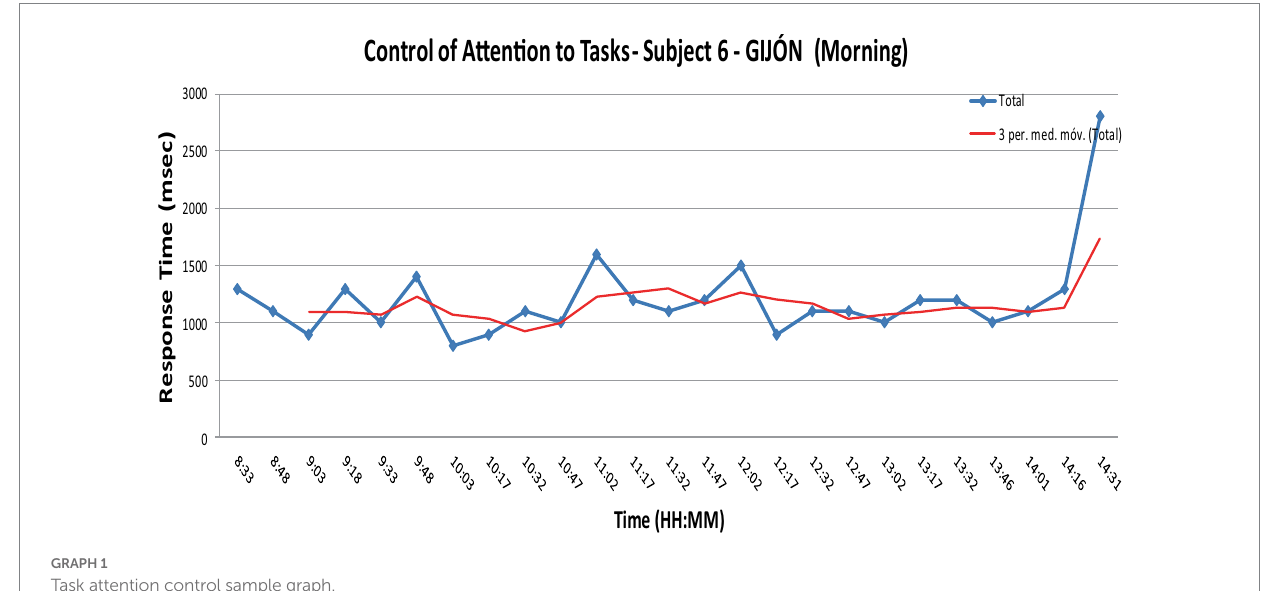
GRAPH 1 Task attention control sample